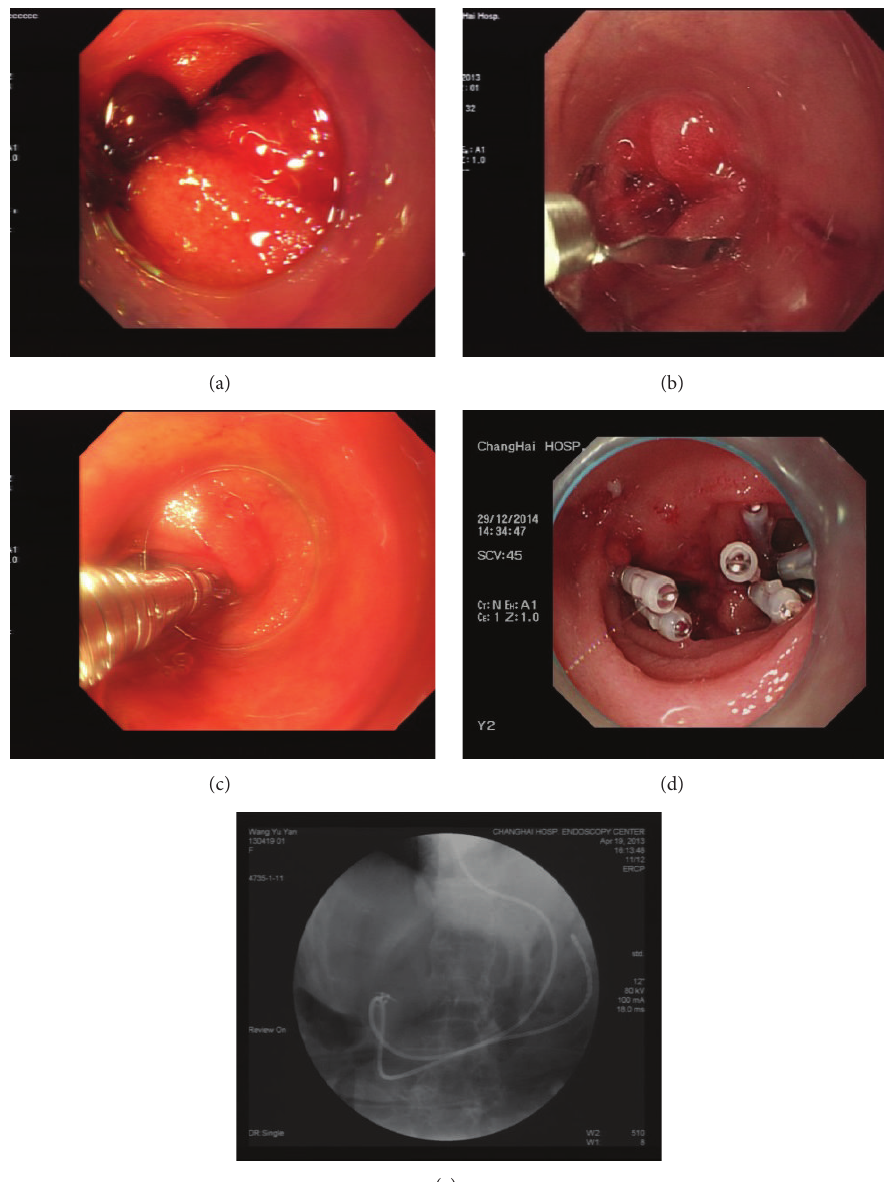
Figure 1: Endoscopic closure by endoclips. The perforation was completely exposed (a). Then, the endoclip was applied to close the perforation (b, c), and the procedure was repeated if the perforation was large in size (d). After the procedure, a nasogastric tube was placed near the perforation site